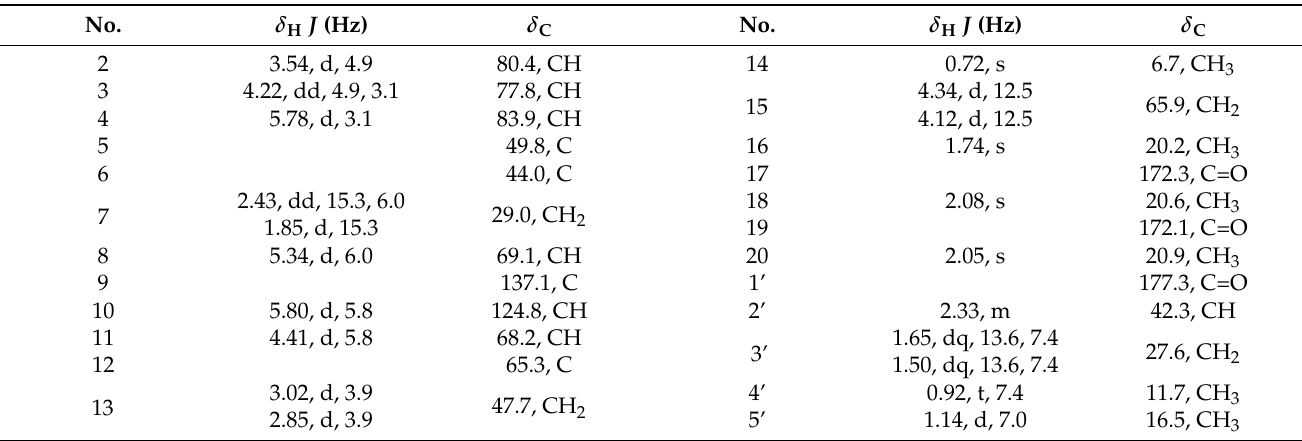
Table 1. 1 H-NMR and 13 C-NMR data for compound 1 (in CD 3 OD, 400 MHz for 1 H-NMR and 100 MHz for 13